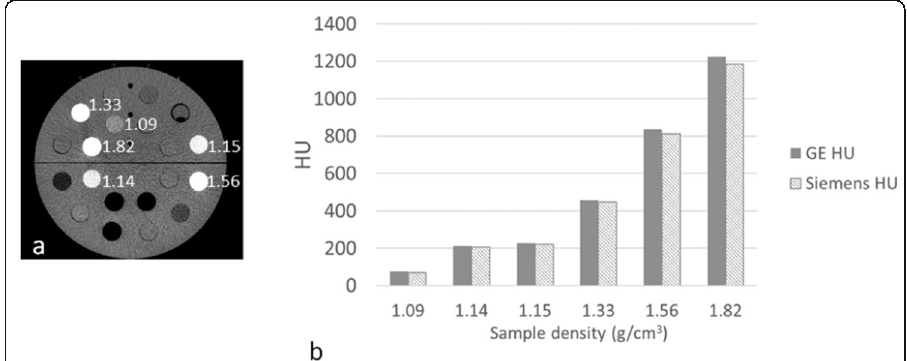
Fig. 4 a GE CT image of the electron density phantom labelled with the density of each sample. The image is displayed in HU. b HU measured on a GE and Siemens CT image of the